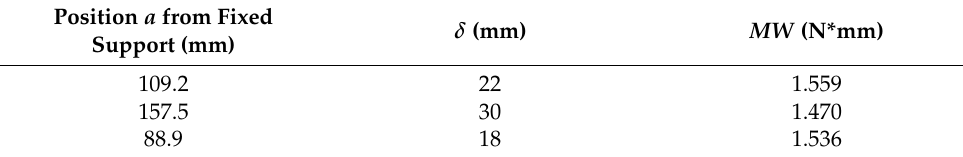
Table 2. Sample mechanical work calculations for a test sample.